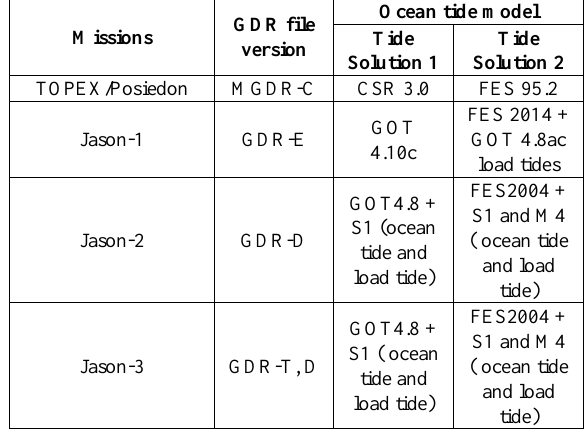
Table 6 . Ocean tide models used in different GDR file